Question: What form of chart is displayed?
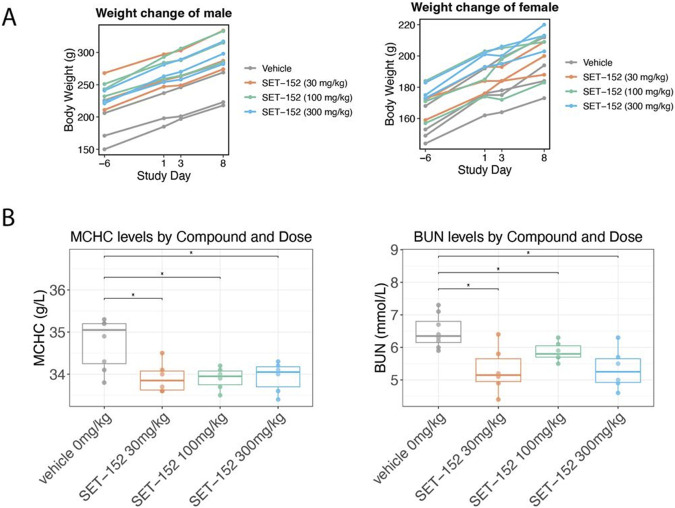
Answer: line